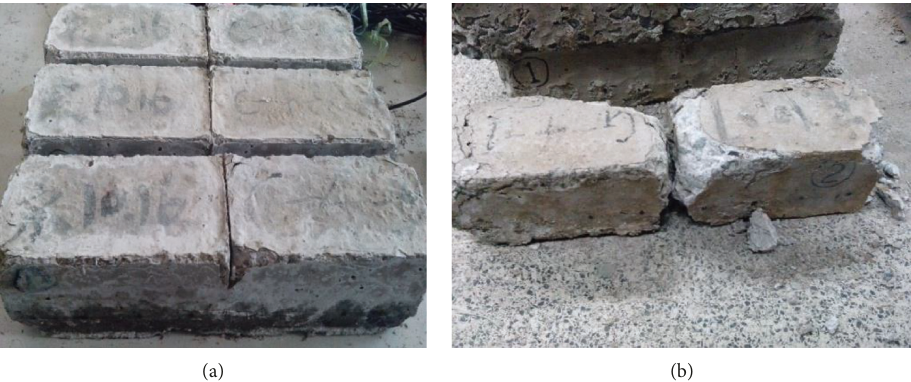
Figure 13: Appearances of the corroded specimens (150 days). (a) Immersion test (15%); (b) wet-dry alternated test.